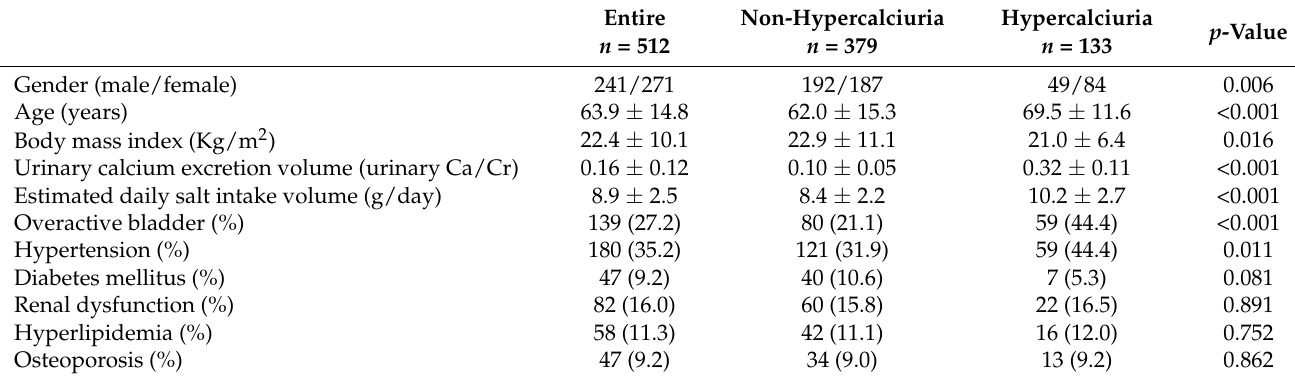
Table 1. Patients’ characteristics by the presence or absence of